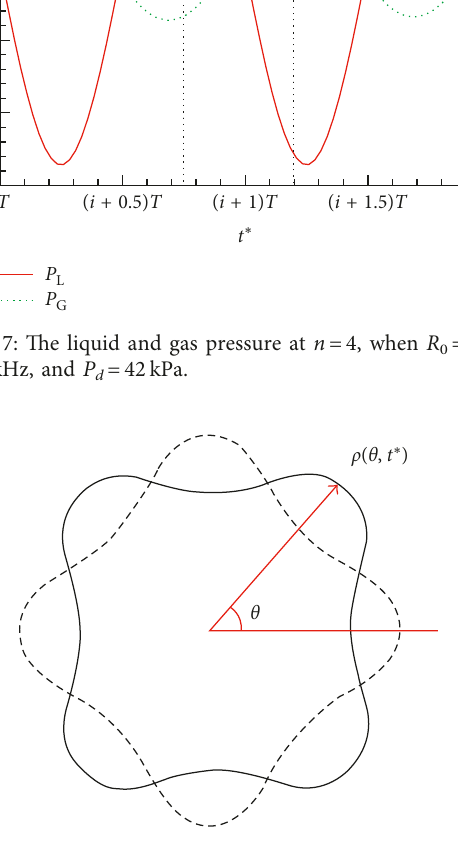
Figure 8: Schematic diagram of the bubble’s shape at n � 4. The solid and dashed lines correspond to oscillation’s extreme shape.